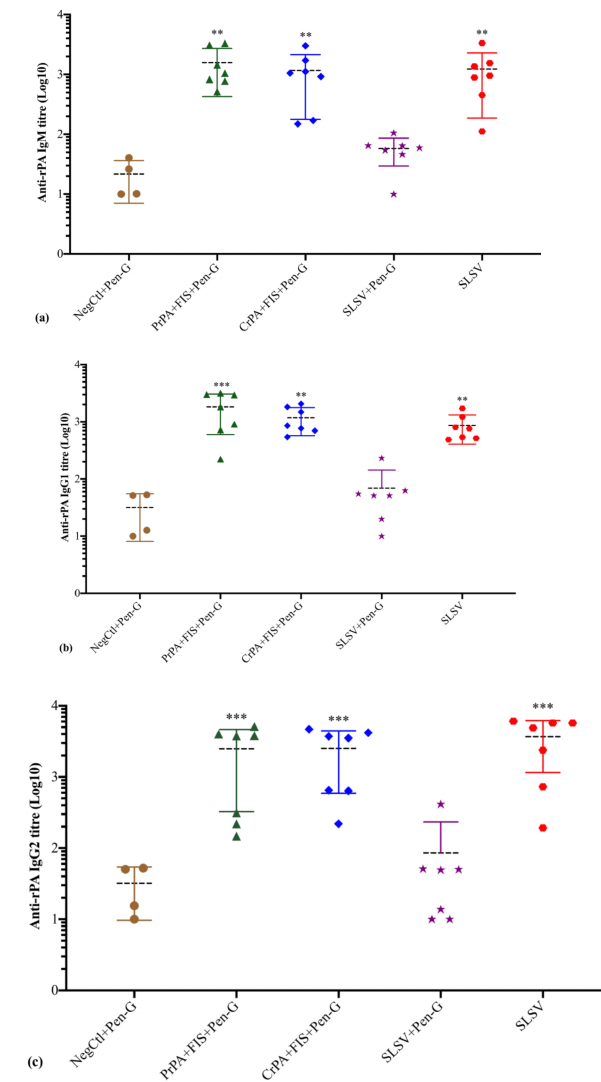
Figure 4. Anti-recombinant protective antigen (rPA) IgM and IgG isotypes (IgG1 and IgG2) titres at week 5 in cattle. The cattle were vaccinated twice at weeks 0 and 3 with PrPA + FIS + Emulsigen-D ® / Alhydrogel ® plus Pen G ( n = 7), CrPA + FIS + Emulsigen-D ® / Alhydrogel ® plus Pen G ( n = 7), Sterne live spore vaccine (SLSV) plus Pen-G ( n = 7), SLSV ( n = 7) and NegCtl (Emulsigen-D ® / Alhydrogel ® plus Pen G) ( n = 4). The IgG titres of each group were compared to the respective titres at week 0 before vaccination (*** p < 0.001, ** p < 0.01, * p ≤ 0.05). ( a ) anti-FIS IgM titres, ( b ) anti-FIS IgG1 titres and ( c ) anti-FIS IgG2 titres. Purified recombinant protective antigen: PrPA; Crude recombinant protective antigen: CrPA; Formalin inactivated Bacillus anthracis spores: FIS; Penicillin-G: Pen-G; Sterne live spore vaccine: SLSV; Negative control: